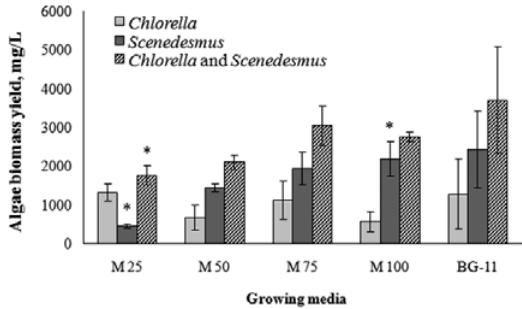
Fig. 3. Biomass yield of Chlorella and Scenedesmus species in wastewater at different concentrations